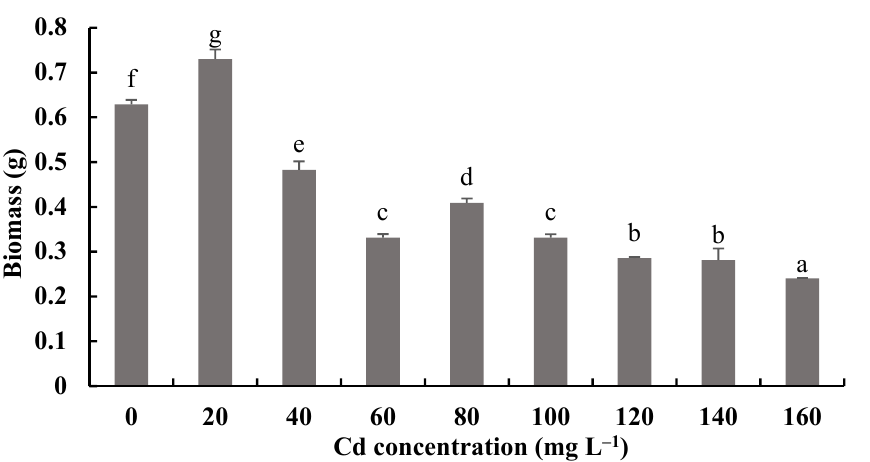
Figure 8. Effects of different concentrations of Cd 2+ on the biomass of H. chrysospermus. Different letters indicated significant difference ( p < 0.05).